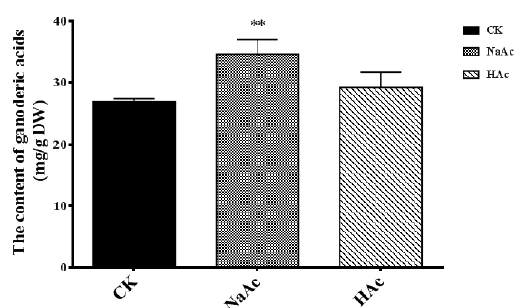
Figure 3. Accumulation of ganoderic acids under the influence of sodium acetate and acetic acid. CK, control check; NaAc, treatment with sodium acetate; HAc, treatment with acetic acid. The error bars indicate the standard deviations from three independent samples. ** indicates statistical significance ( p < 0.01) compared to the CK strain.